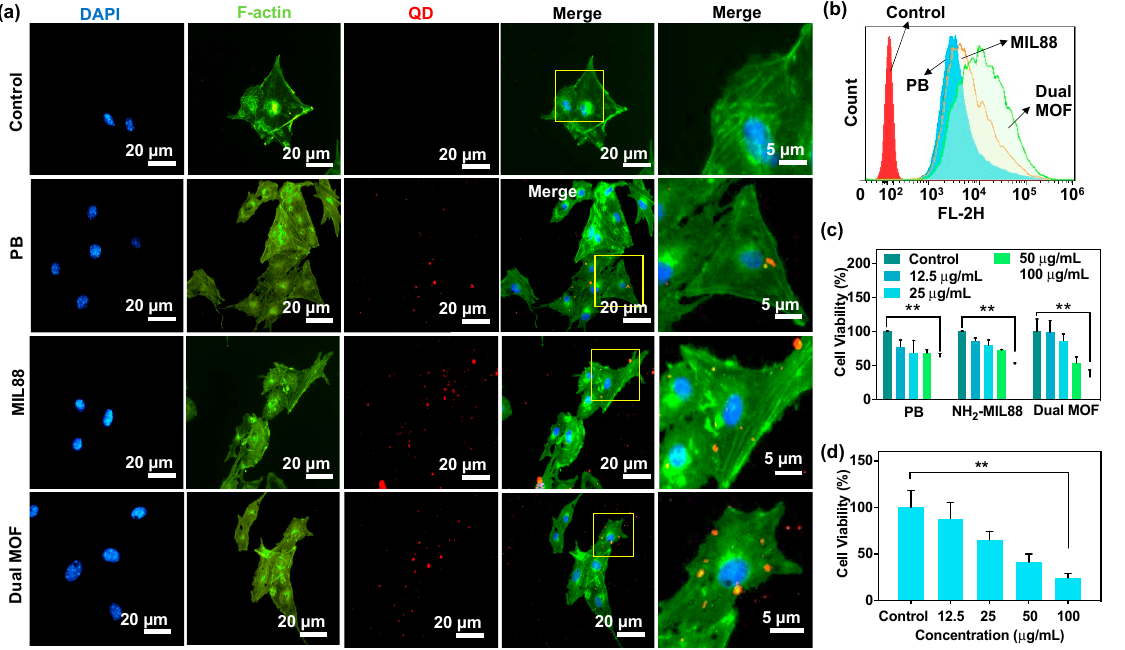
Figure 3. ( a ) CLSM images of cellular uptake of B16F10 incubated with PB, MIL88, and dual MOF labeled by QDs. Blue, red, and green fluorescence represent nucleus staining with DAPI, particle staining with QDs, and cytoskeleton staining with F-actin, respectively. ( b ) Flow cytometry analysis of PB, MIL88, and dual MOF after 24 h of incubation in B16F10 cells. ( c ) Cell viability of B16F10 cells in the presence of PB, MIL88, and dual MOF solution at various concentrations. ( d ) Cytotoxicity of B16F10 cells incubated with CQ-loaded dual MOF at various concentrations. Quantitative significant sta- tistical data were calculated via Student’s t-test, ** p < 0.01.